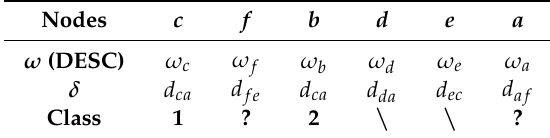
Table 2. The density-energy and distance (determined by local density) of six nodes.